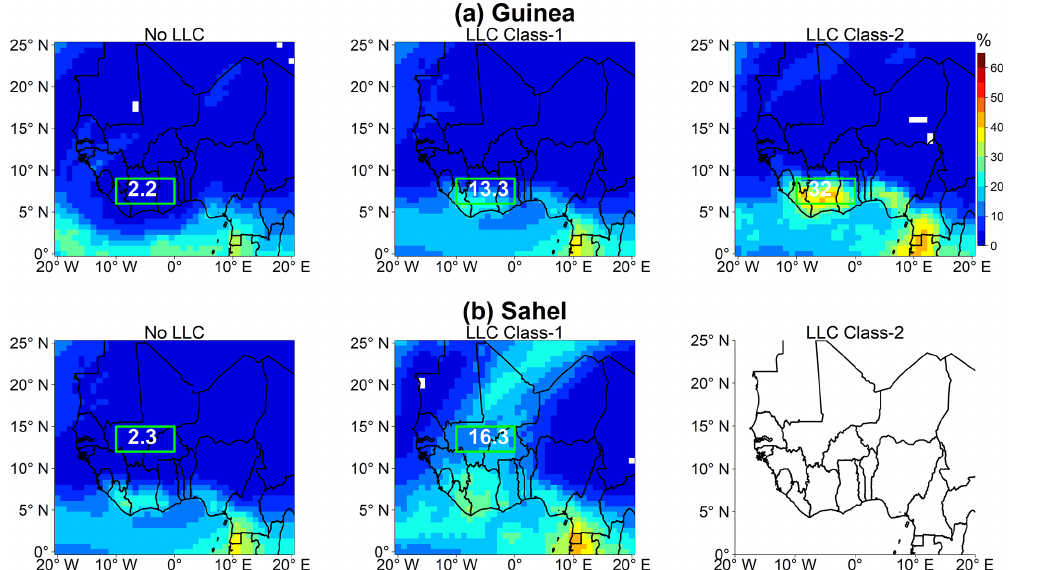
Figure 11. Same as Fig. 10 but for DJF. No event of LLC Class-2 has been extracted in the Sahel region during DJF, hence the empty